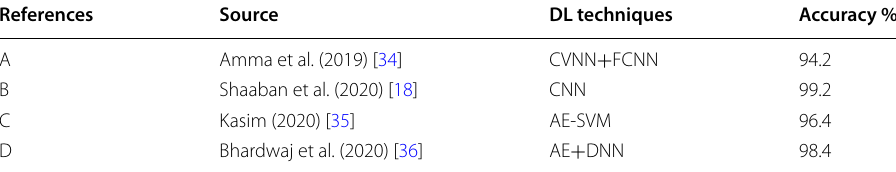
Table 3 Accuracy of deep learning approaches for DDoS attacks detection on NSL-KDD Dataset